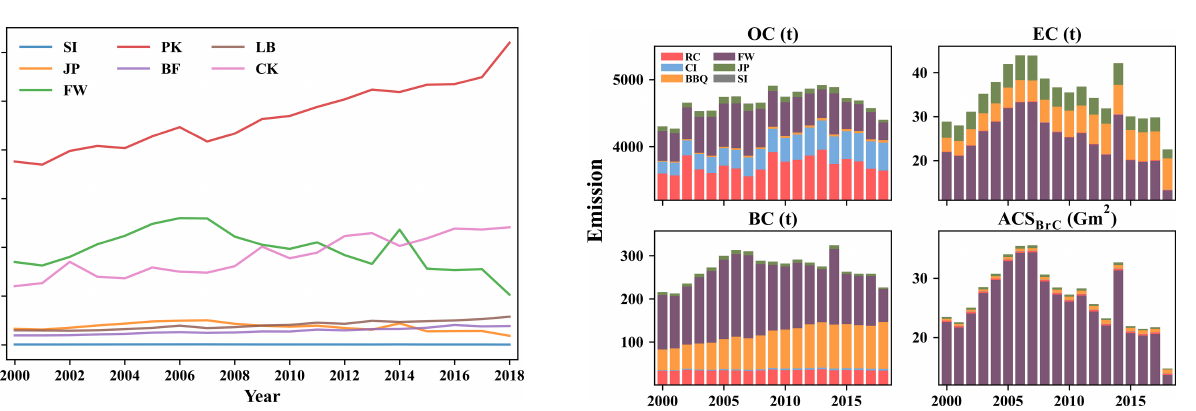
Figure 4. Total CA emissions from the FMSs in China from 2000 to 2018. The abbreviations used in the figure are as follows: SI – sacrificial incense, JP – joss paper, FW – fireworks, BBQ – barbe- cue, RC – residential cooking, and CI – catering